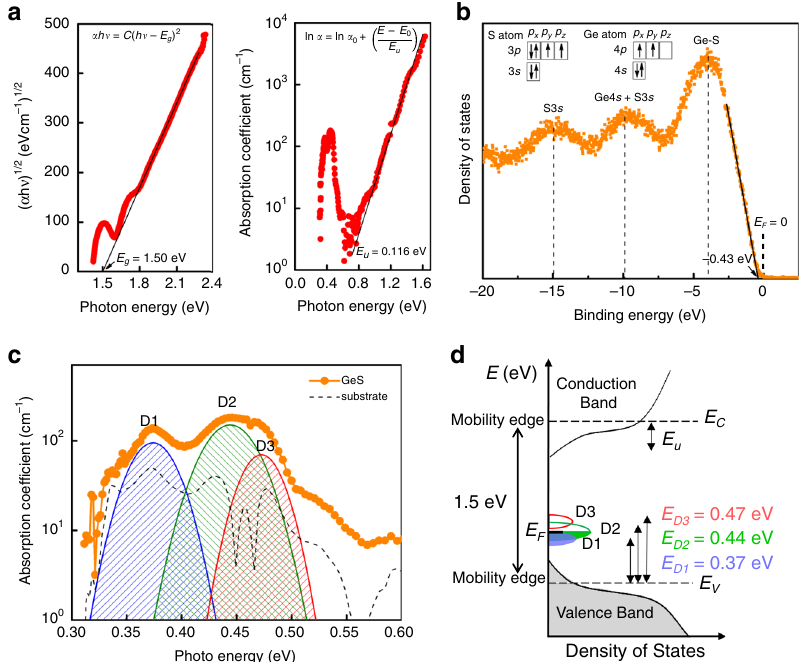
Fig. 4 Band structure of amorphous GeS. a Tauc plot of ( α h ν ) 1/2 versus photon energy h ν of amorphous GeS fi lm indicating the width of the energy gap. The thickness of the GeS fi lm is around 780 nm. Variations of the absorption coef fi cient with the photon energy revealing the Urbach tail. b X-ray excited valence band spectra of GeS fi lm showing the Fermi level. c PDS spectrum of GeS fi lm showing the location of localized state. d Reconstructed qualitative energy band schematic of GeS glass, where E C represents the conduction band minimum. Filled traps are those fi lled with colors, empty traps (without electrons) being left